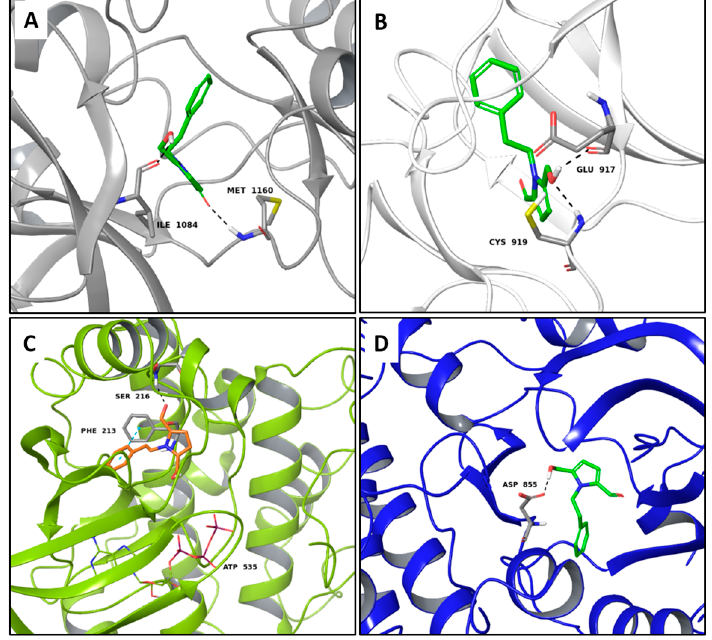
Figure 3. Molecular interactions of inotopyrrole and the anticancer targets: ( A ) Protein target, c-Met (PDB: 2WGJ). Protein is shown as a gray cartoon while ligand is shown as green carbon sticks; ( B ) Protein target, VEGFR2 (PDB: 3VHE). Protein is shown as a white cartoon while ligand is shown as green carbon sticks; ( C ) Protein target MEK2 (PDB: 3POZ). Protein is shown as a light green cartoon while ligand is shown as orange sticks; ( D ) Protein target EGFR. Protein is shown as a blue cartoon while ligand is shown as green sticks. H-bonds s and π - π interactions are shown as dashed black and cyan lines, respectively. Amino acid residues involved in the interactions are shown as gray sticks.